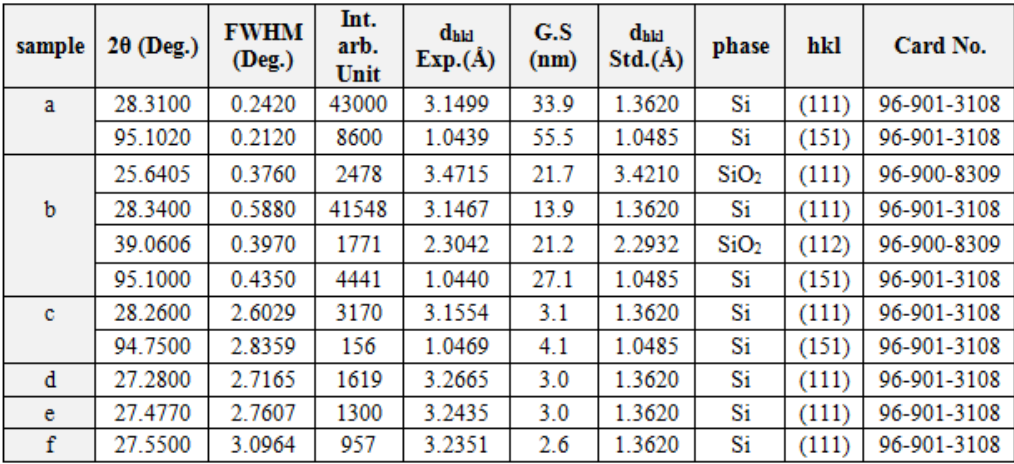
and standard d values of hkl hkl